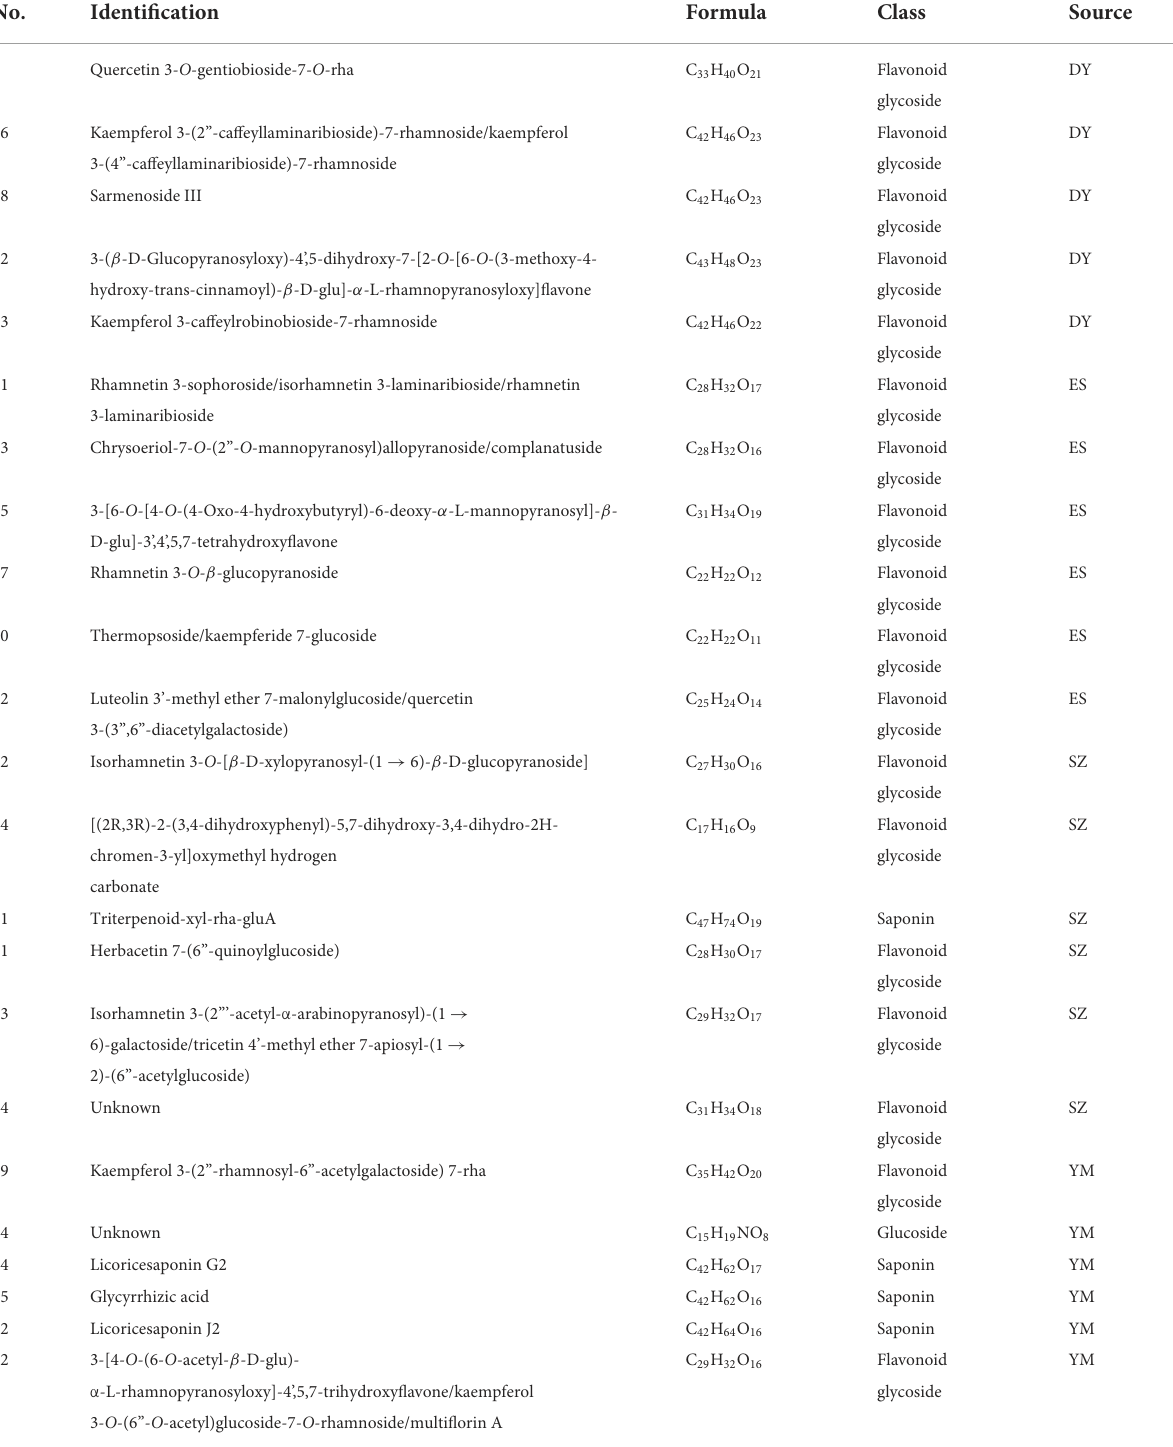
TABLE 2 Components for SVM